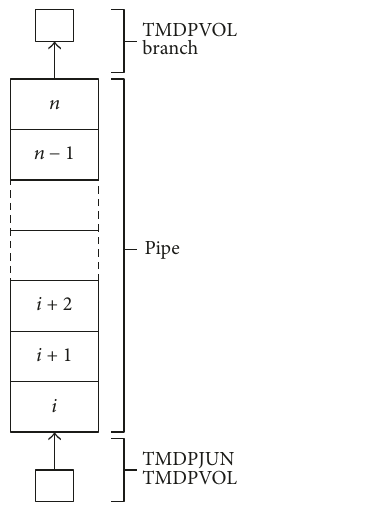
Figure 6: Model and nodalization of the pipe for